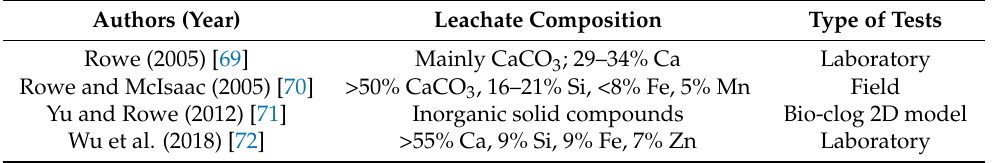
Table 4. Selected components of artificial leachate used in laboratory tests.